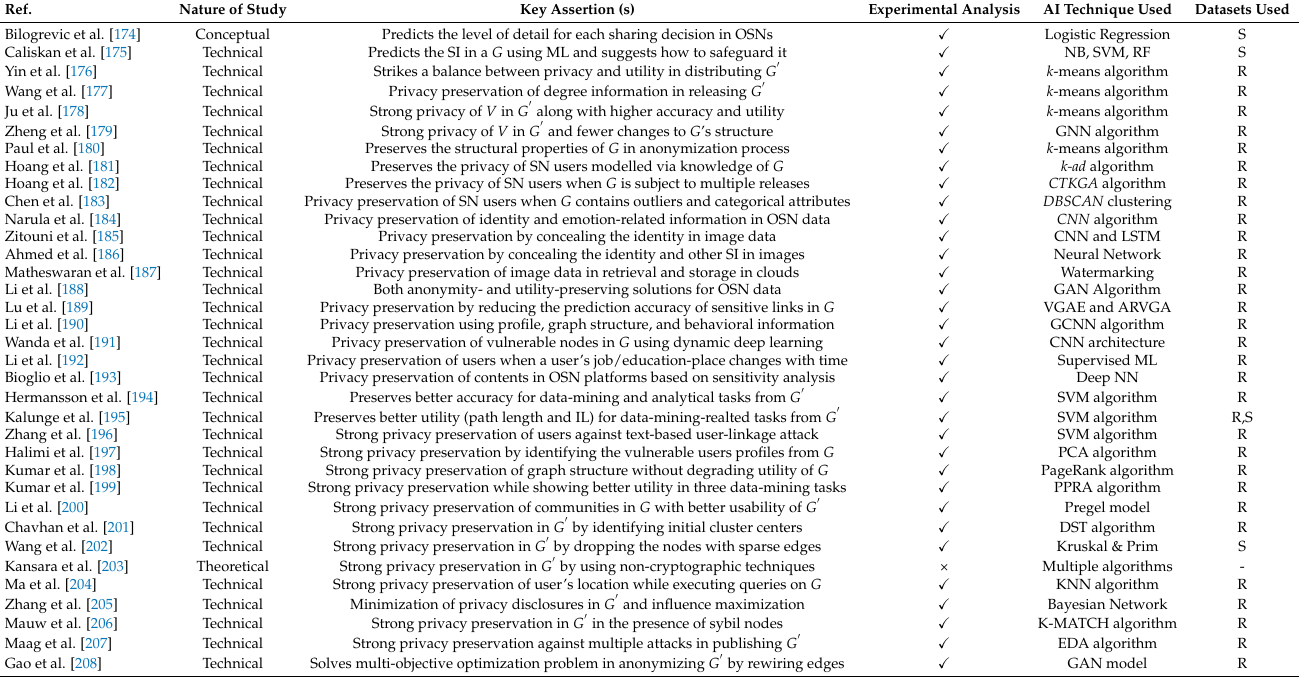
Table 6. Summary and comparison of state-of-the-art AI-based G anonymity techniques.